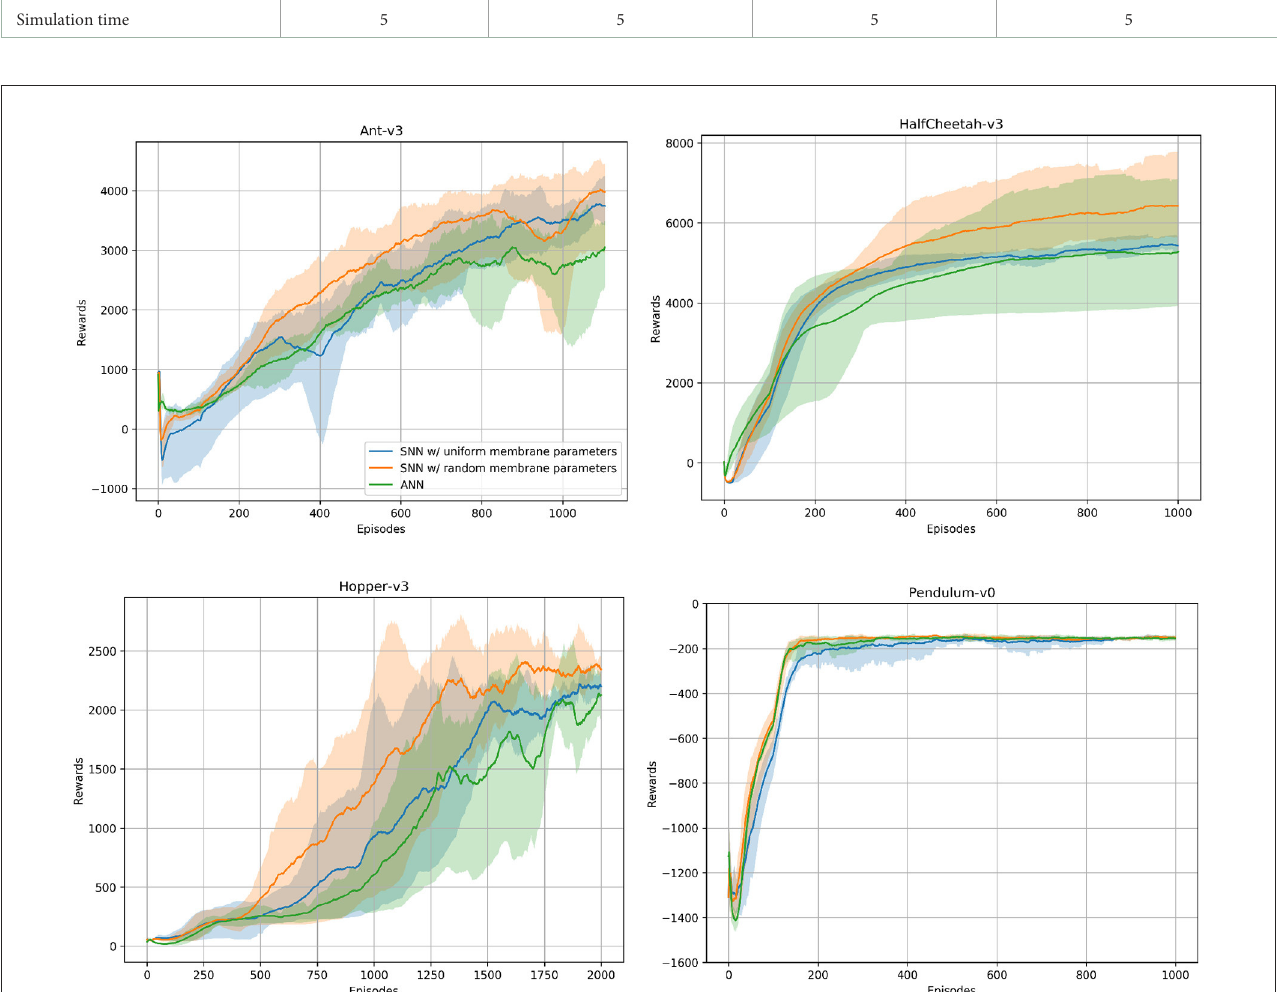
FIGURE5 ANN and SNN training curves on the Ant-v3, HalfCheetah-v3, Hopper-v3, and Pendulum-v0 environments from OpenAI Gym. Two SNN training curves are to be seen, one using uniform and the other one using randomized membrane parameters. Solid lines are mean rewards (window size of 100 episodes) averaged over five runs with random initialization seeds. Shaded areas show the standard deviation. The number of episodes varies across environments, as each environment might have a different maximum number of timesteps per episode, i.e.,